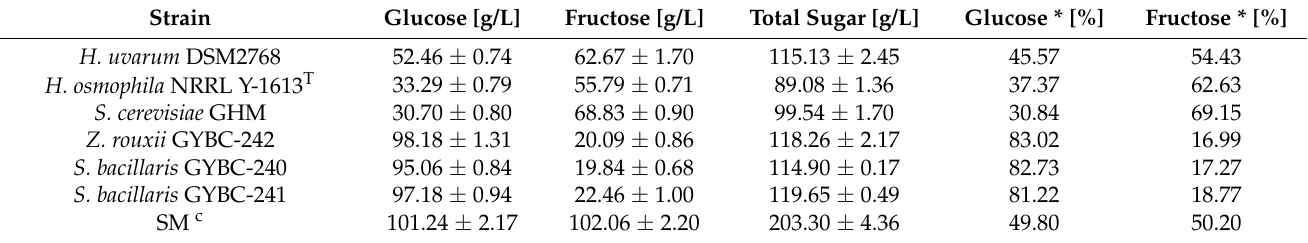
Table 4. Analysis of glucose, fructose and total sugar in yeast fermentations with SM-mix a, b . Strain Glucose [g/L] Fructose [g/L] Total Sugar [g/L] Glucose * [%] Fructose * [%] 52.46 ±